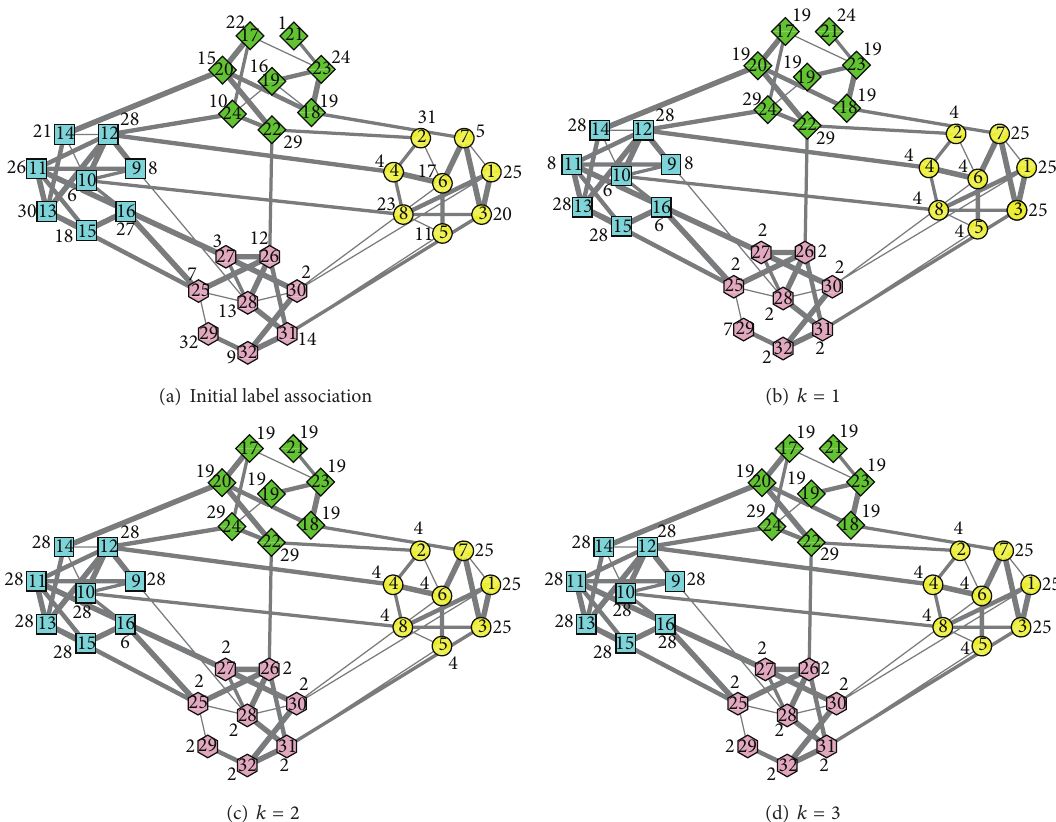
Figure 9: A community detection process on a weighted computer-generated network using LPAp.